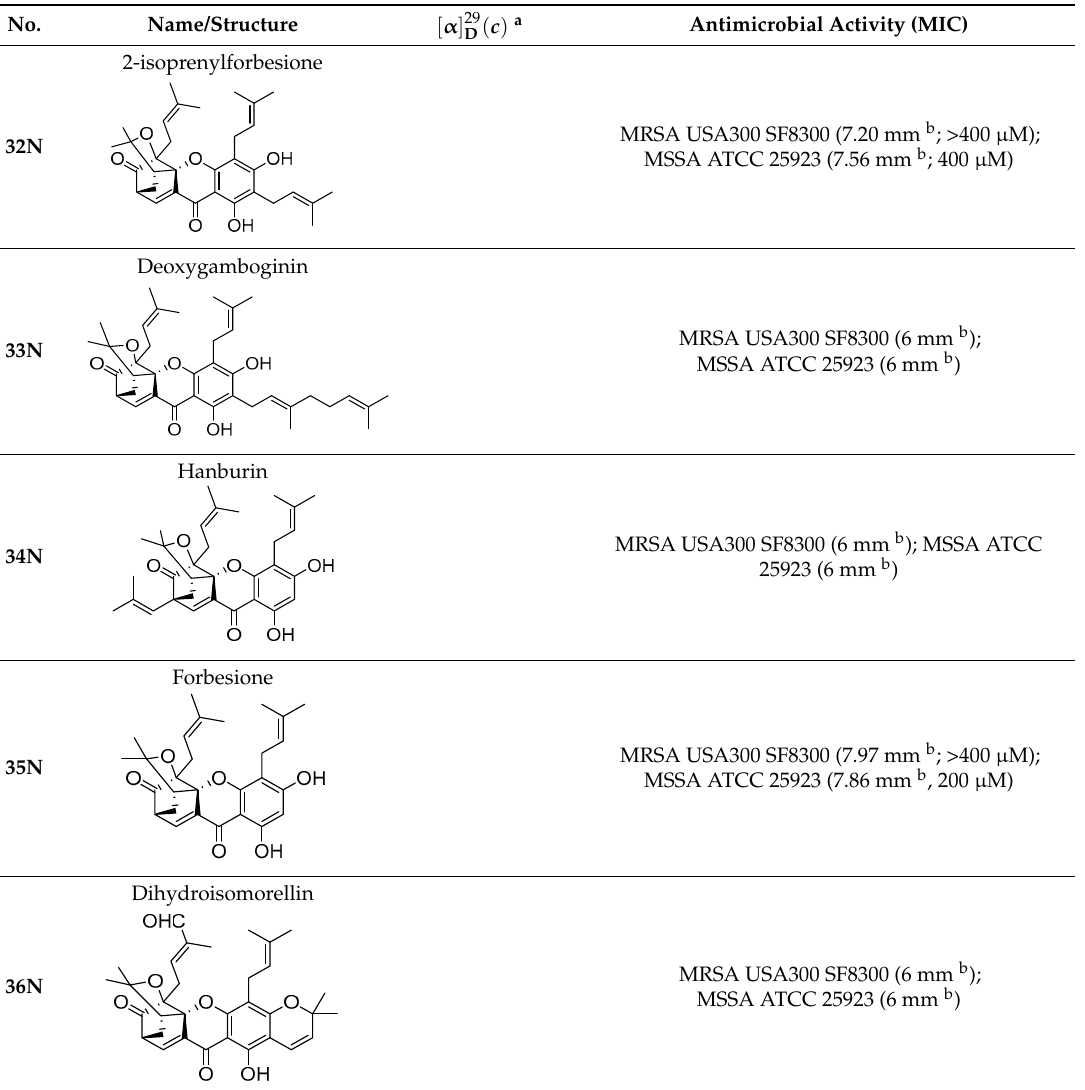
Table 5. Antimicrobial activity of natural caged xanthones with pyran group.